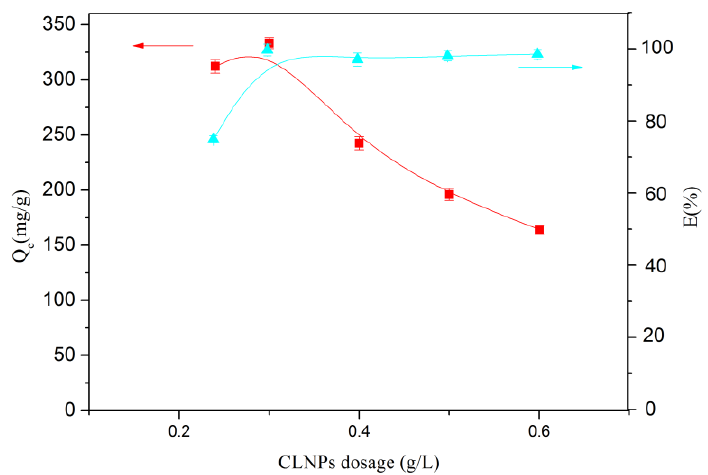
Figure 7. Effect of dosage on the adsorption of Pb(II) on CLNPs ( C 0 = 100 mg/L, t = 180 min, temperature = 30 °C, pH = 6.03).